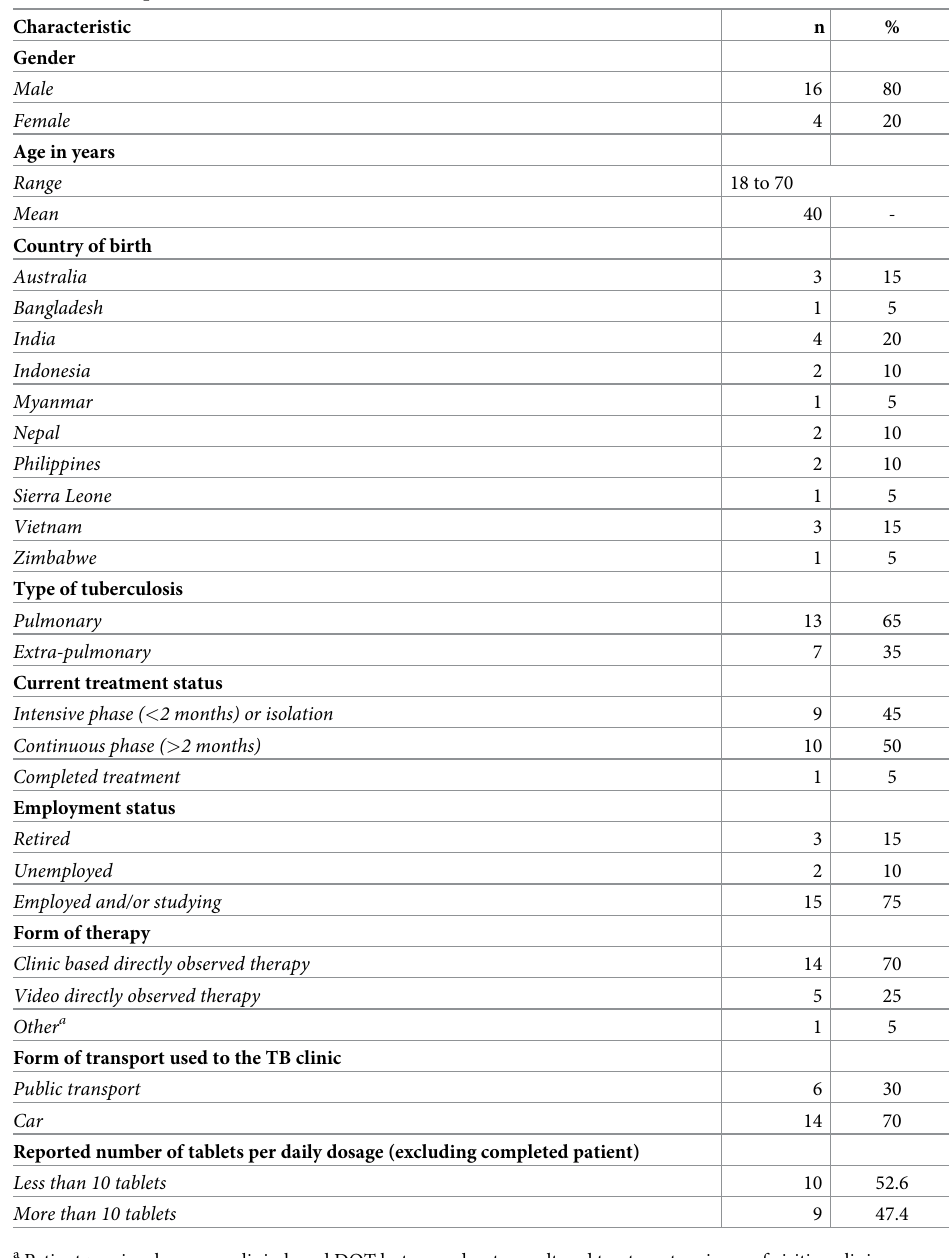
Table 1. Participant